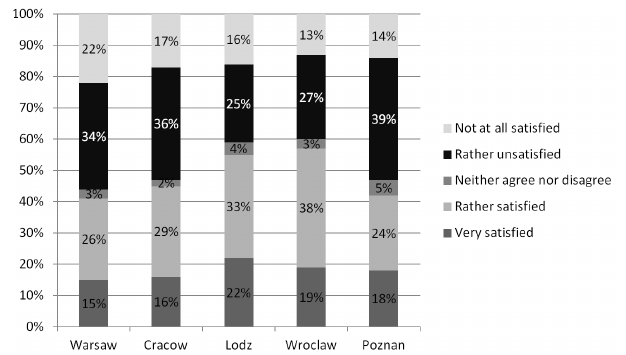
Figure 5. Assessment of noise level in the biggest Polish cities in 2018.